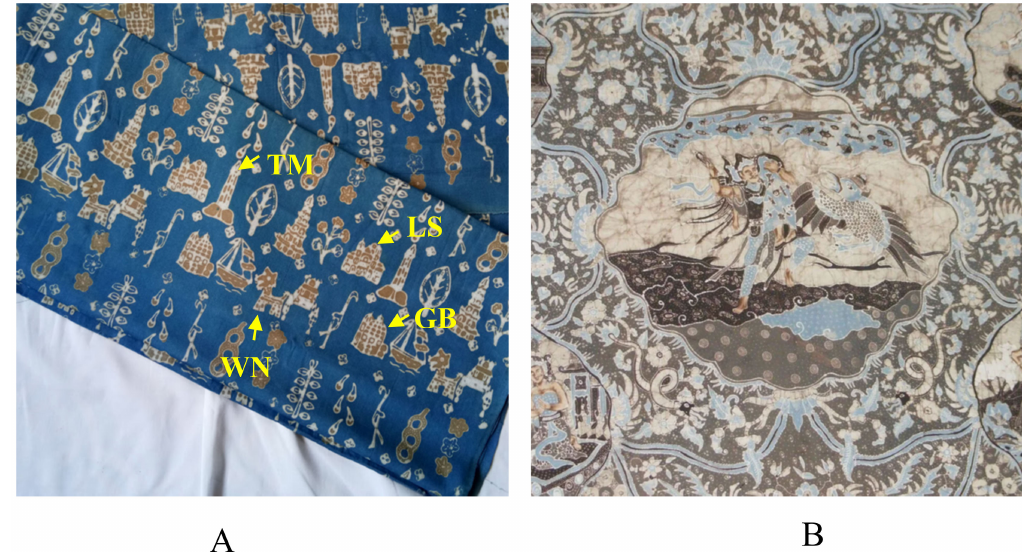
Figure 1. The most popular motifs of the Zie Batik products by themes. The iconic landmark of Semarang City or more popular with Semarangan motifs ( A ) and the legend of the Javanese Puppet stories ( B ). In the Semarangan motifs, the natural dye batik is fully decorated with the iconic buildings of Semarang City, such as Tugu Muda (TM), Lawang Sewu (LS), and Gereja Blendug (GB), as well as